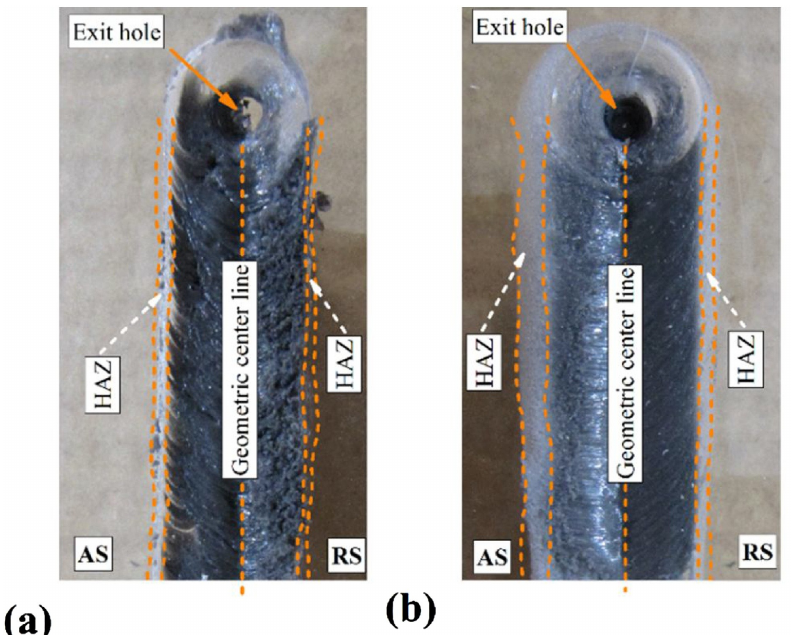
Figure 2. Surface material flow of joint at ( a ) 1940 rpm/45 mm min − 1 and ( b ) 960 rpm/90 mm min − 1 Reprinted with permission from Ref. [75]. 2018, H.A. Derazkola, M. Elyasi